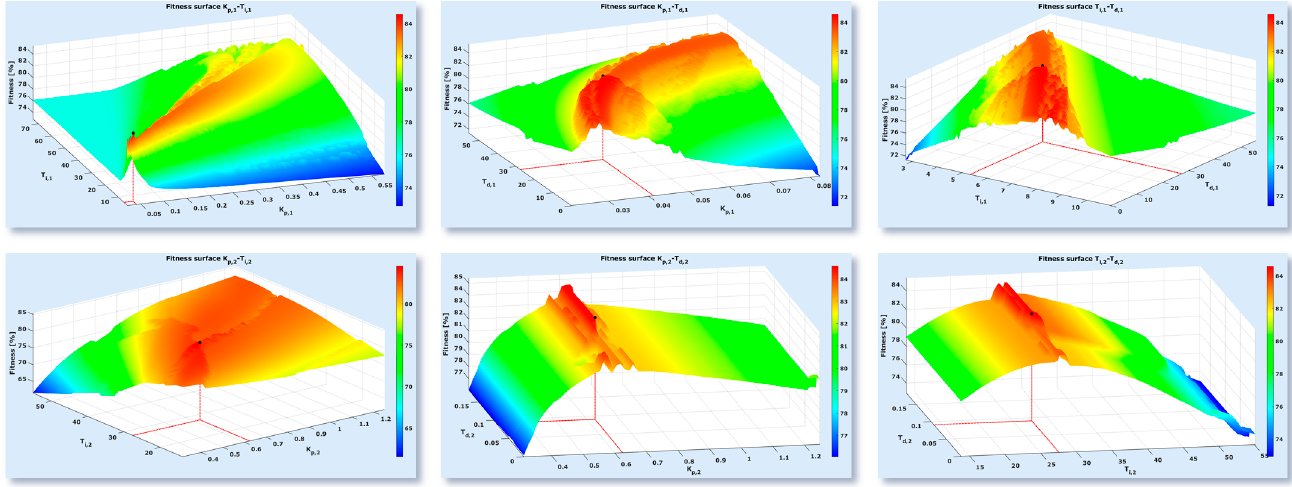
Figure 7. Example of fitness surfaces.